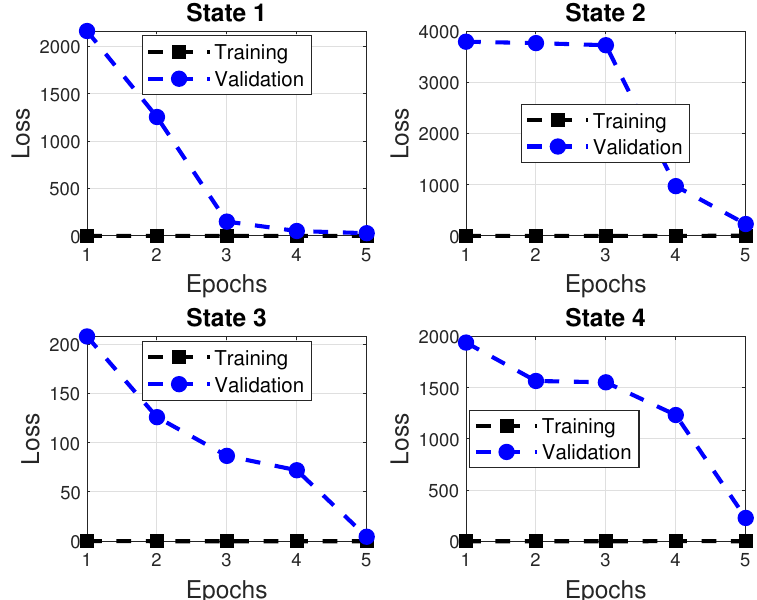
Figure 7. Training and validation MSE losses for Random